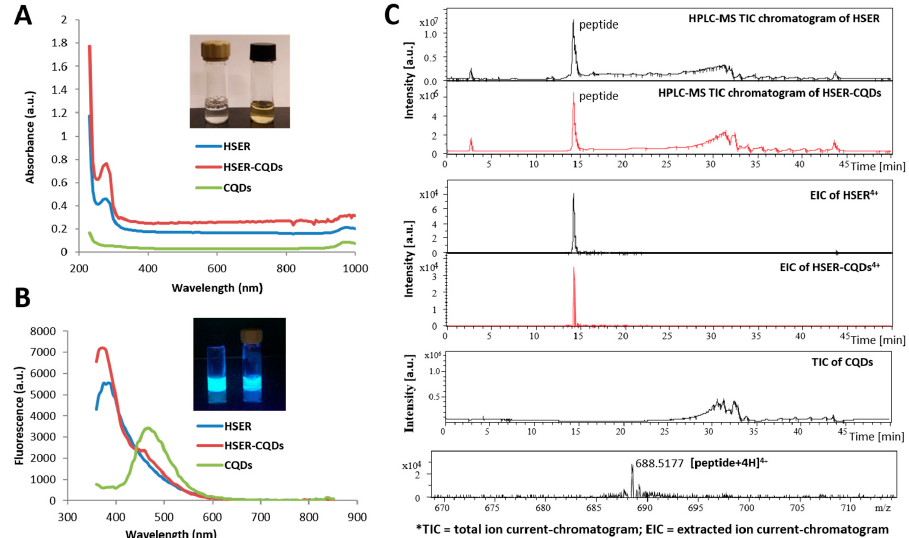
Figure 2. ( A ) The fluorescence spectra were obtained with the excitation of 320 nm and emission at range of 360 to 850 nm; and the bottle with black cap contains Carbon Quantum Dots(CQDs) and the brown-capped bottle contains the HSER-CQDs conjugate showing bluish fluorescence. ( B ) The Absorbance spectra obtained at a range of 230 to 1000 nm. ( C ) Samples were separated on column Zorbax eclipse AAA C18 (3.5 µm particles; 150 × 4.6 mm) using the KNAUER PLATINblue V6900A HPLC system, which consisted of two P 1 pumps and an autosampler AS 1 (Knauer, Berlin, Germany). Mobile phase A consisted of water with +0.1% formic acid. Mobile phase B consisted of acetonitrile with +0.1% formic acid. Gradient mode: 0 min 3% B– > 30 min 97% B– > 40 min 97% B– > 42 min 3% B– > 50 min 3% B– > STOP. Flow rate was 0.5 mL/min. Injected sample volume was 20 µL. Prior to injection the samples were diluted with mobile phase A to get a final concentration 10 µg/mL. HPLC was coupled with ESI-QqTOF mass spectrometer Bruker Maxis Impact (Bruker Daltonik GmbH, Bremen, Germany). The following parameters of mass spectrometer were used: End-plate offset potential, 500 V; capillary potential, 4500 V; nebulizer gas (N 2 ) pressure, 4 bar; drying gas (N 2 ) flow rate, 6 L/min − 1 ; drying temperature, 300 °C. Mass range was set from 50 to 3000 m / z . Positive ion mode was used. Prior to HPLC-MS analysis a mass spectrometer was calibrated using ESI-TOF tuning mix.